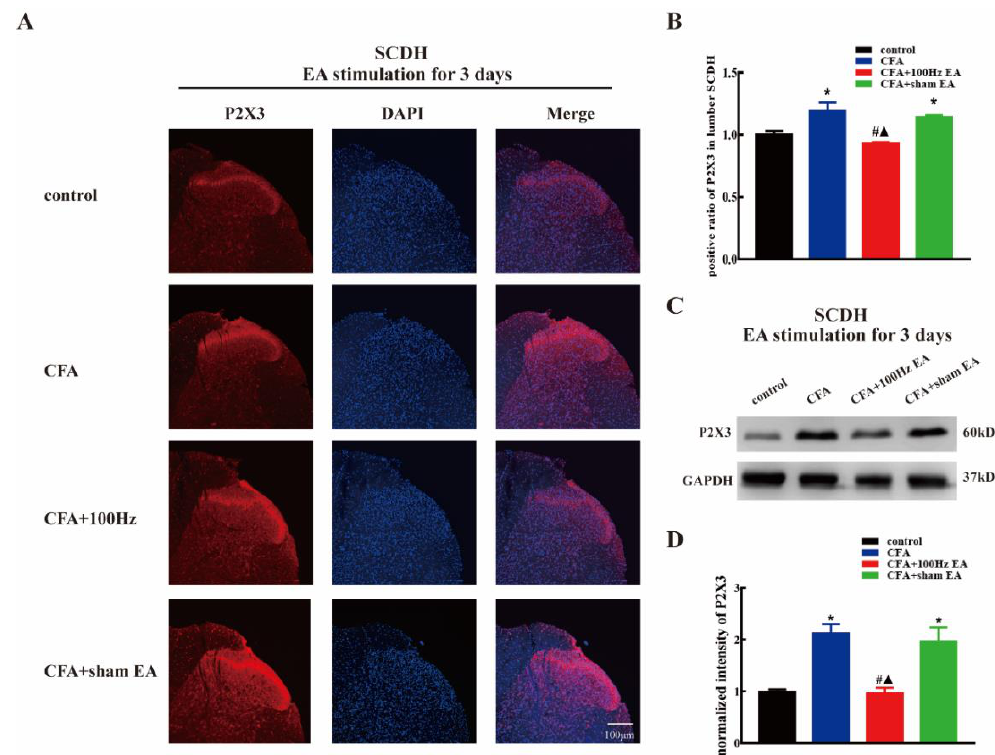
Figure 3. The 100Hz EA stimulation for 3 days inhibited the up-regulation of P2X3 in (spinal cord dorsal horn) SCDH of inflamed rats. ( A ). Representative images of SCDH immunofluorescence staining from the control, CFA, CFA + 100 Hz EA and CFA + sham EA groups. Scale bars = 100 μm. ( B ) Mean intensity analysis of P2X3-ir in SCDH in each group. Data are presented as the mean ± SEM, n = 3. ( C ) Representative western blotting images of SCDH in each group. ( D ) Relative protein level of P2X3 in SCDH from different groups. Data are presented as the mean ± SEM, n = 6. * P <0.05, compared with the control group; # P <0.05, compared with the CFA group; ▲ P <0.05, compared with the CFA + sham EA group.